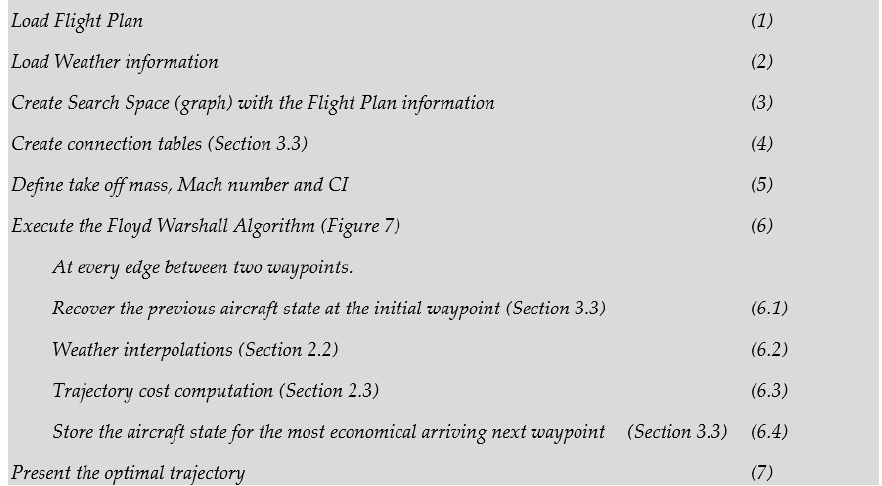
Figure 9. The 3D optimization algorithm pseudo ‐ code.